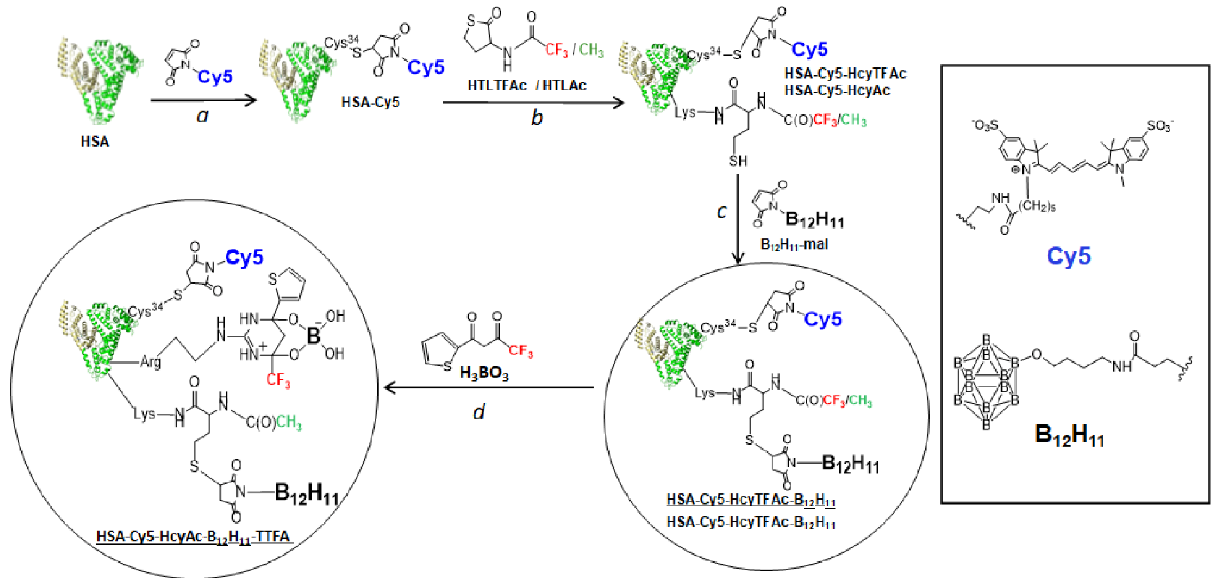
Figure 1. Synthetic routes to obtain the multifunctionalized serum albumin architecture — HSA-Cy5-HcyTFAc-B 12 H 11 and HSA-Cy5-HcyAc-B 12 H 11 -TTFA. Drug carrier (shown schematically as a heart-like structure) — human serum albumin (HSA). Effector — B 12 H 11 : therapeutic agent. Note that homocysteine thiolactone derivatives (HTLTFAc and HTLAc) are used as a functional handle. HTLTFAc and TTFA are used as a source of fluorine atoms. Optical imaging — fluorescent dye Cy5 conjugated with Cys-34.